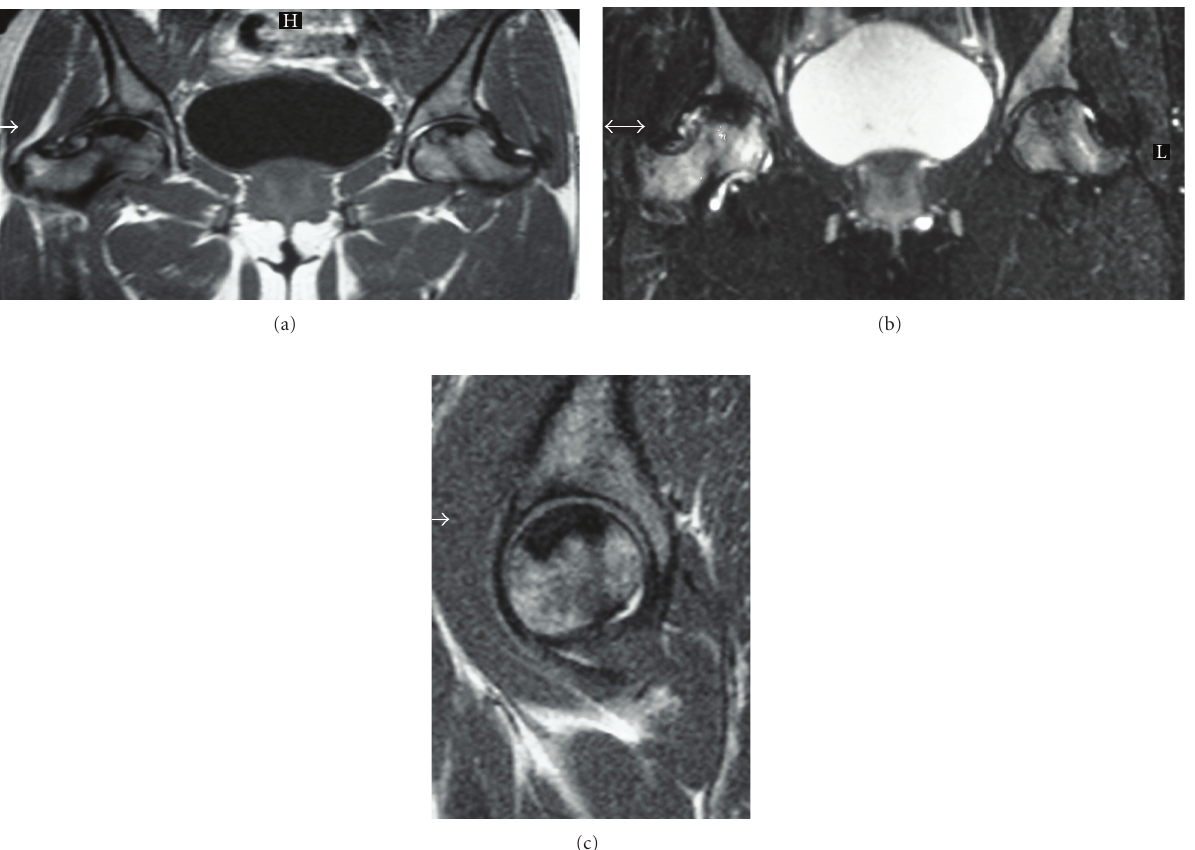
Figure 10: (a), (b), and (c) T1W coronal, T2FS (fat saturated) coronal and T1W sagittal MRI of the pelvis and right hip of a patient with sickle cell anaemia. Advanced avascular necrosis with subchondral collapse is seen superiorly in the femoral heads as evidenced by low signal areas on both T1W and T2W images. Additional areas of high signal, particularly in the right femoral neck on the T2FS images depict further areas of